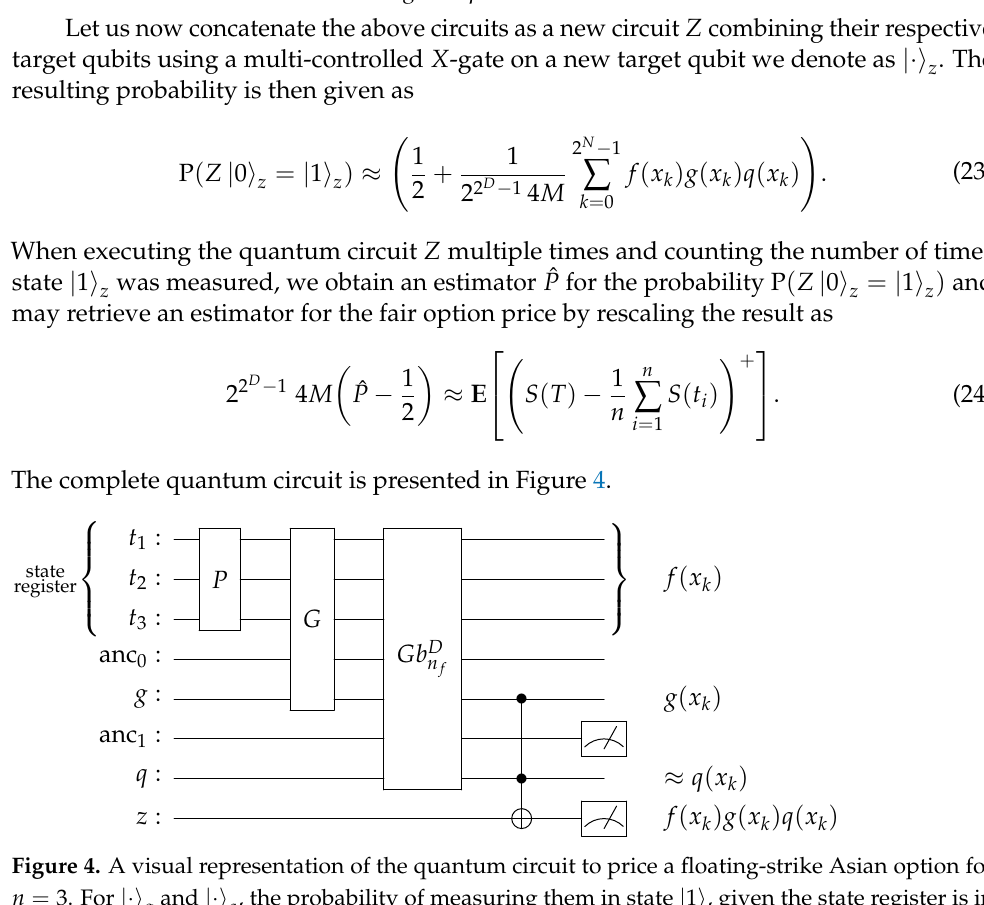
| 1 (cid:105) , given the state register is in